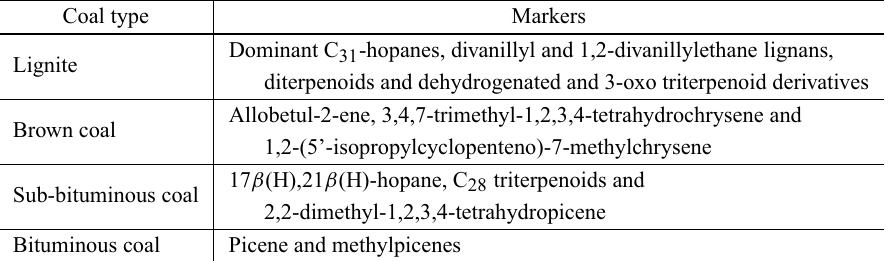
Dominant source-specific molecular markers for smoke from each coal